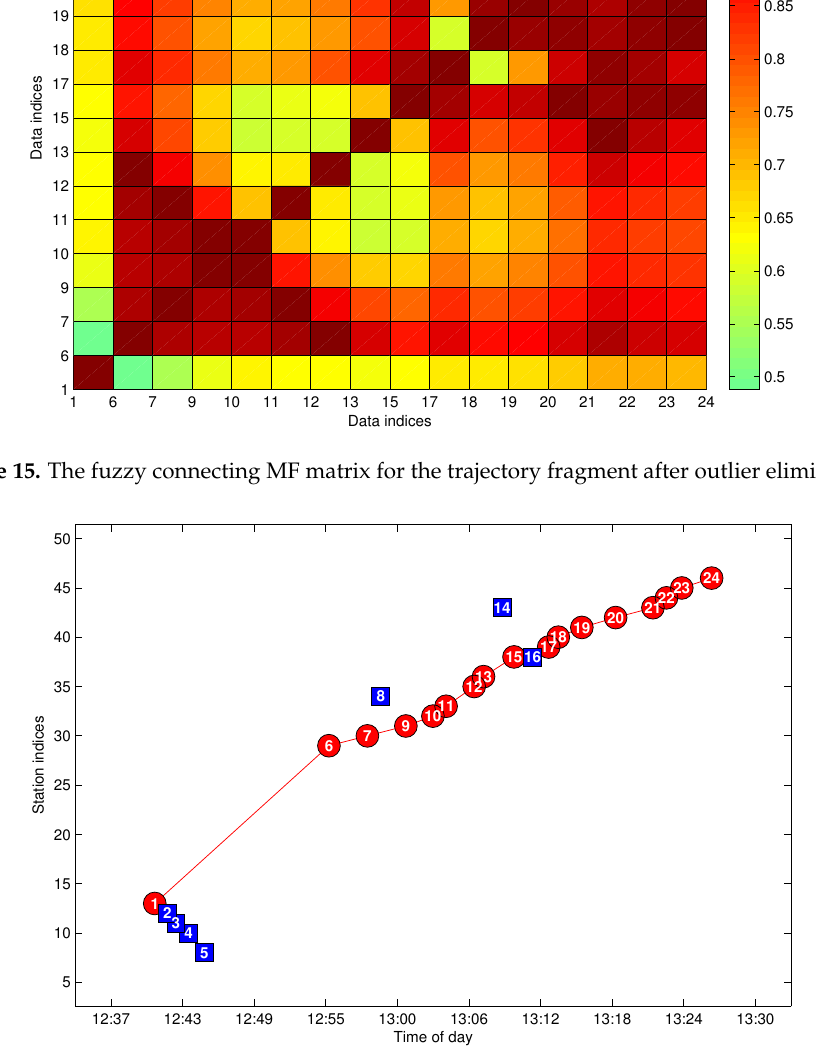
Figure 16. The cleaned trajectory